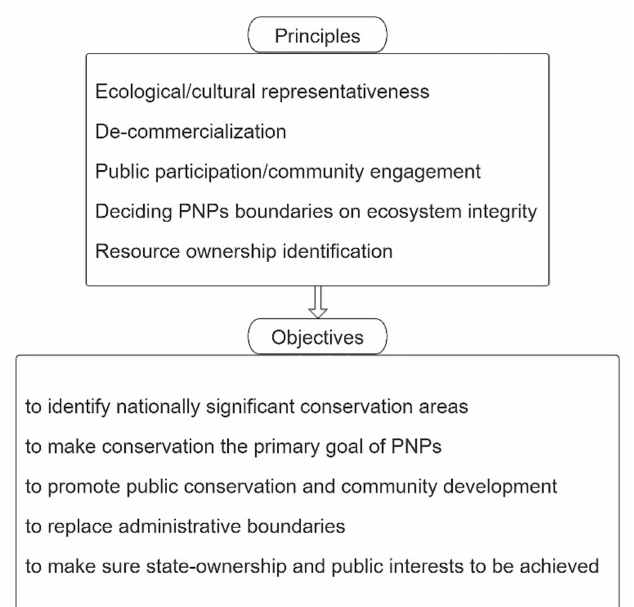
Figure 5. Principles and objectives of the PNP